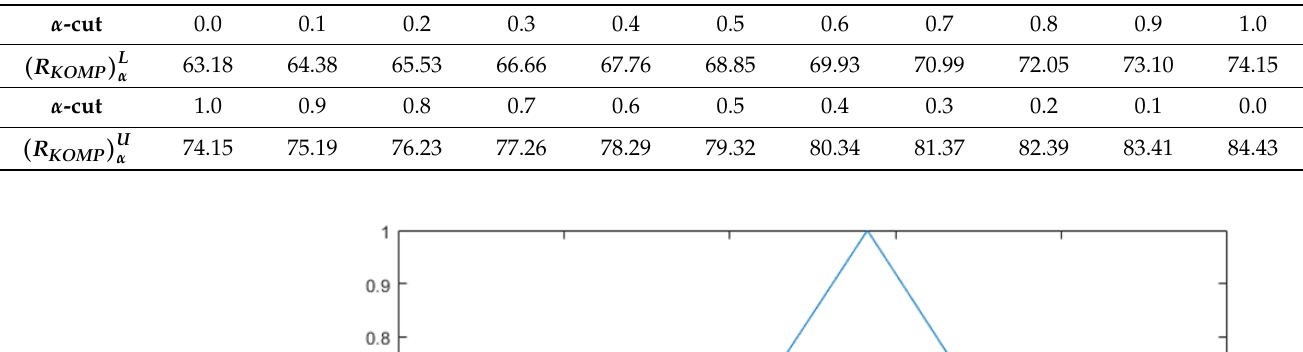
Figure 10. Graphical representation of the equipment component rating values for all combina- tions.